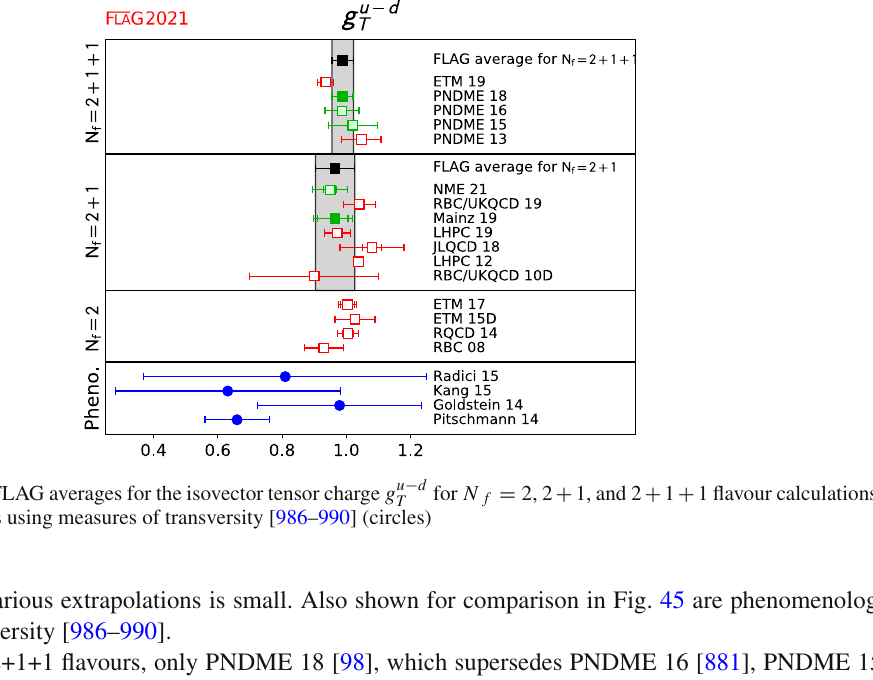
for N f = 2, 2 + 1, and 2 + 1 + 1 flavour calculations. Also shown T